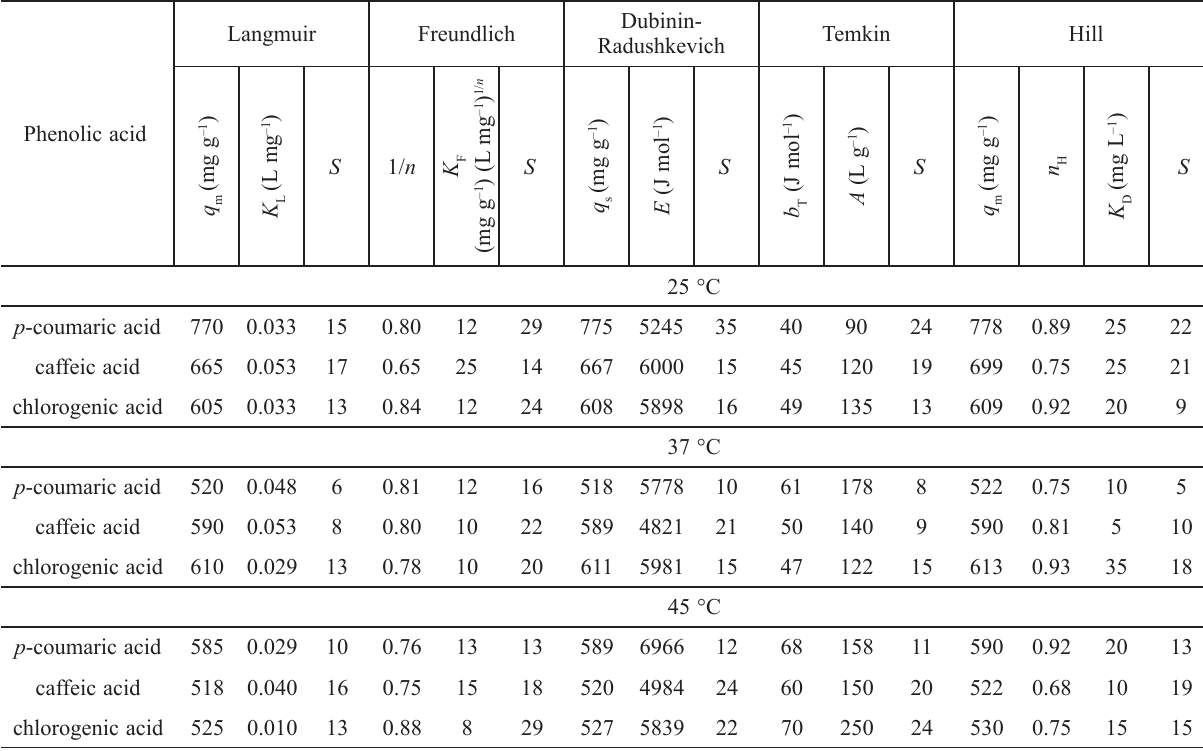
Table 2 – Apparent, theoretical, predicted parameters of Langmuir, Freundlich, Dubinin-Radushkevich, Temkin, and Hill adsorp- tion isotherms at 25, 37, and 45 °C (pH 5.5)